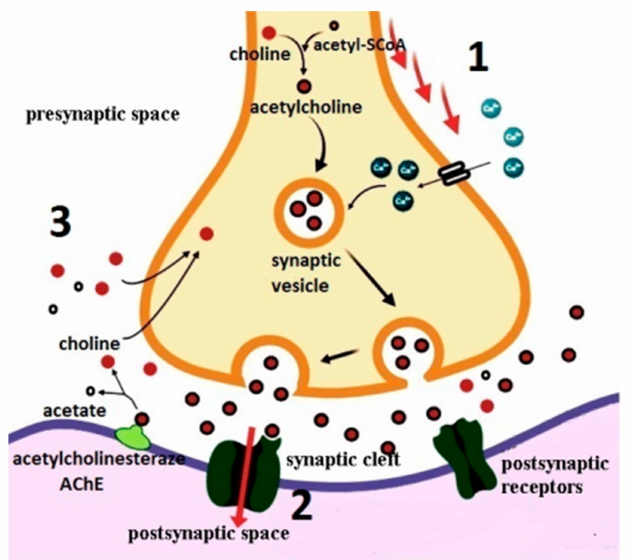
Figure 1. Schematic representation of the acetylcholine release course and cholinergic hypothesis of AD. (1) Action potential causing influx of Ca 2 + and subsequent membrane docking of synaptic vesicles; (2) acetylcholine binds to receptors initiating a graded depolarization in the post synaptic cell; (3) AChE catalyzes the breakdown of acetylcholine and choline molecules are reabsorbed by the presynaptic neuron. ACh, acetylcholine; AChE, acetylcholinesterase; Acetyl-CoA, acetyl coenzyme